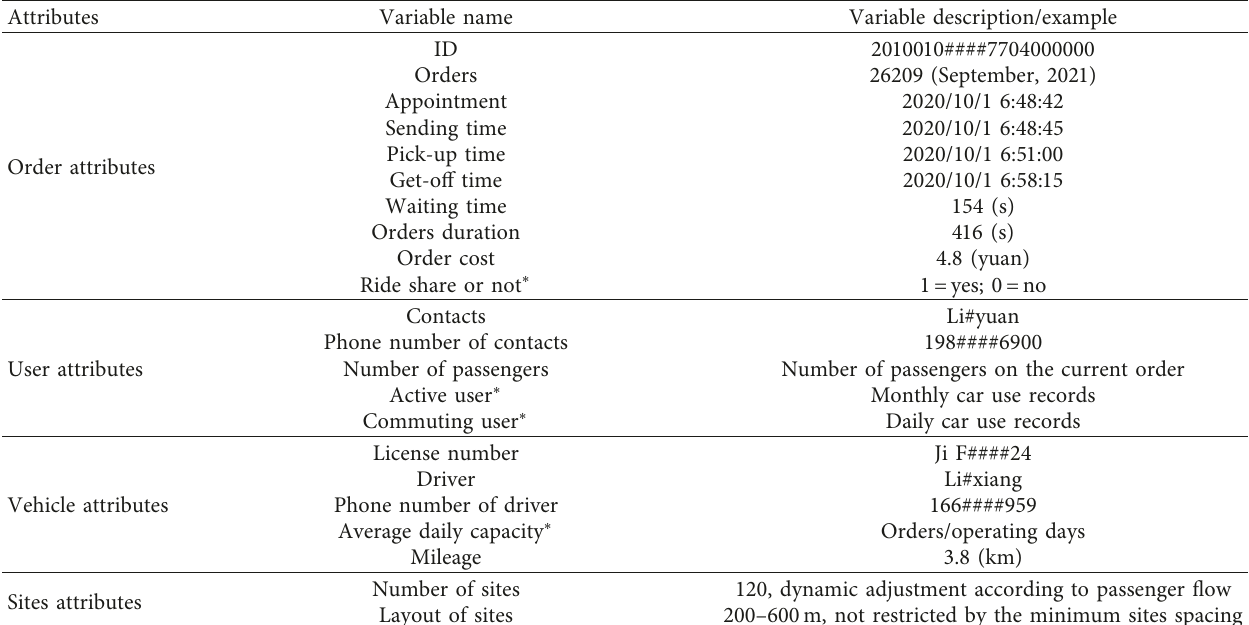
Table 1: Attributes of Xiong’an bus sharing